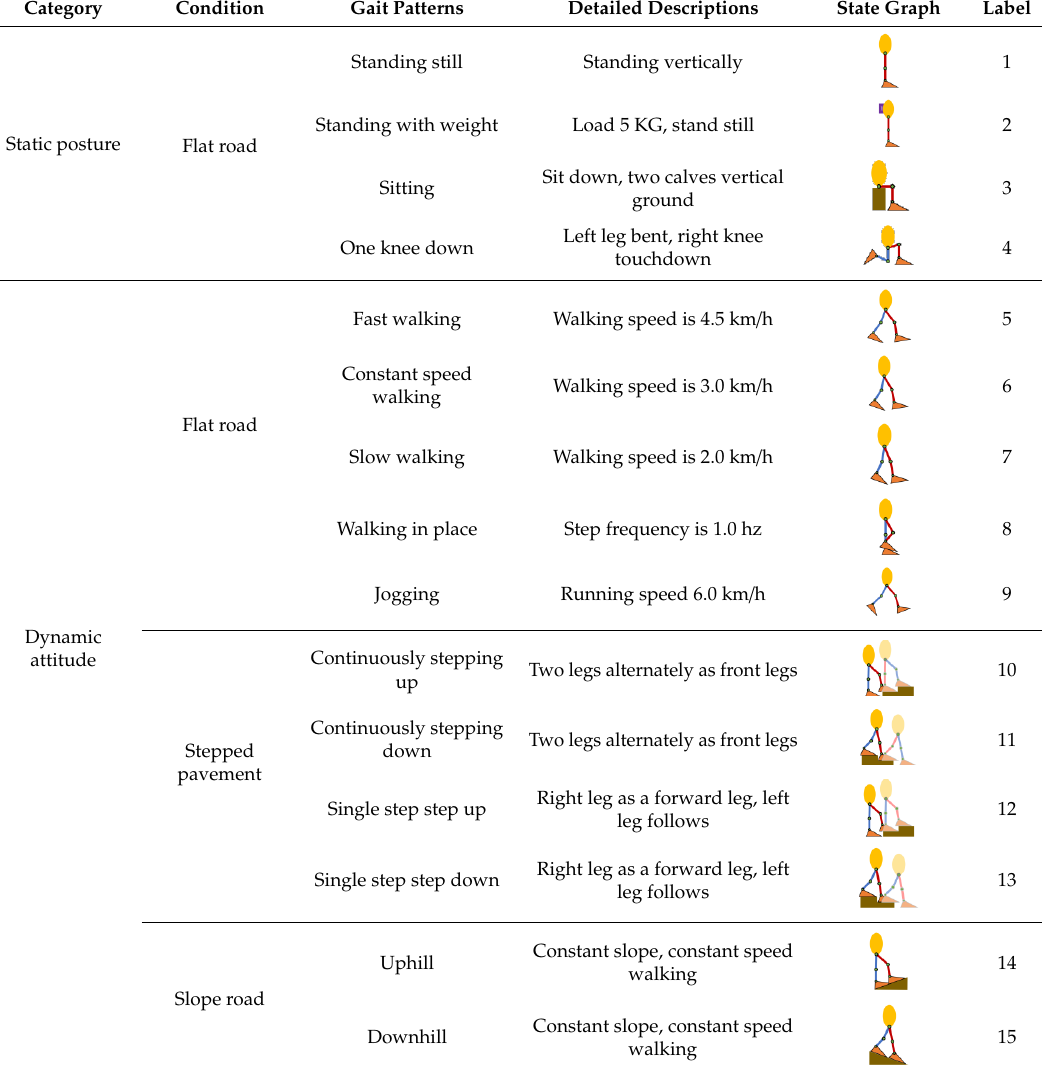
Table 1. Selected gait patterns.